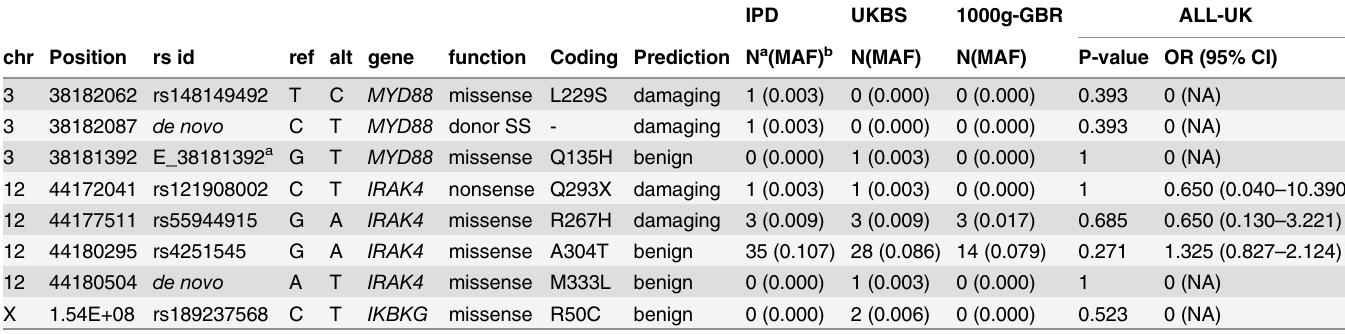
Table 2. Non-synonymous (missense), splice site (SS) and nonsense variants identified in IPD cases and